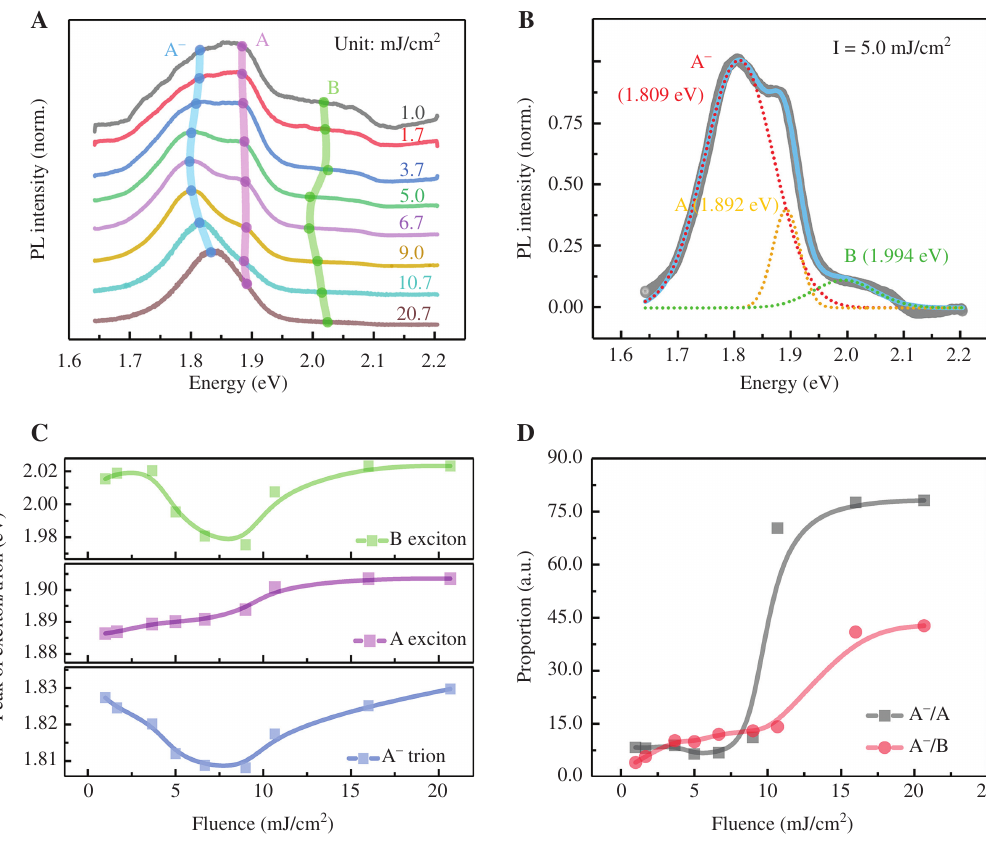
/GST heterostructure. Figure 2: PL signal of the MoS 2 (A) PL of the heterostructure at different modulating fluence ranging from 1 to 20.7 mJ/cm 2 . The PL peak of A exciton, B exciton, and A − trion are indicated by purple, green, and blue solid lines, respectively. (B) Typical Gaussian fitting of the MoS 5 mJ/cm 2 modulating fluence. The PL peaks of A − trion, A exciton, and B exciton were 1.809, 1.892, and 1.994 eV respectively. The dashed lines are the Gaussian fits, the gray solid line is the measured data, and the green solid line is the sum of the three Gaussian fittings. (C) Energy peak change of A exciton, B exciton, and A − trion with increasing modulating fluence. (D) Intensity ratio changes of A − /B and A − /A with increasing modulating